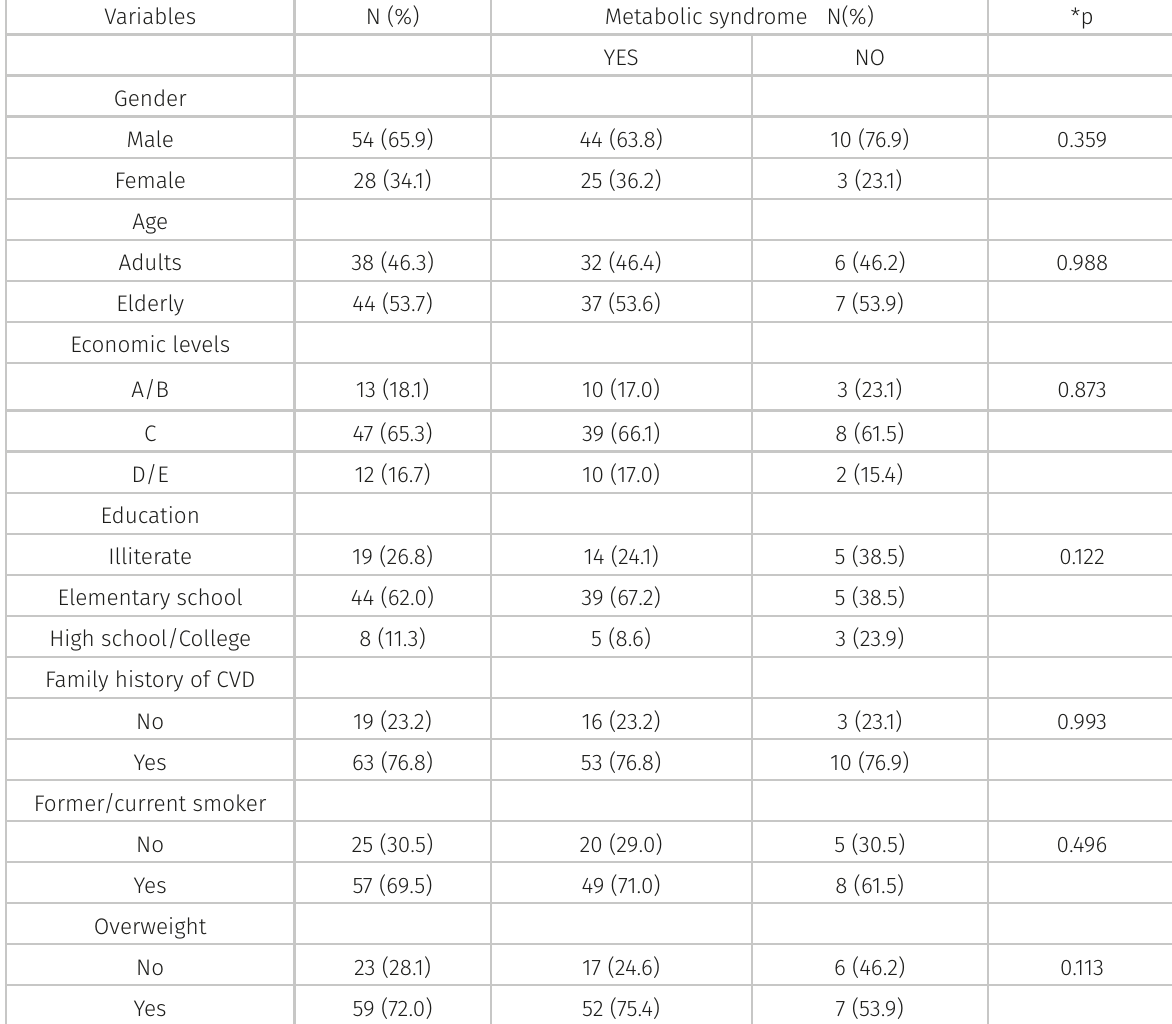
Table I. Sociodemographic, clinical and anthropometric characteristics of patients with established atherosclerosis disease in Pelotas, RS,